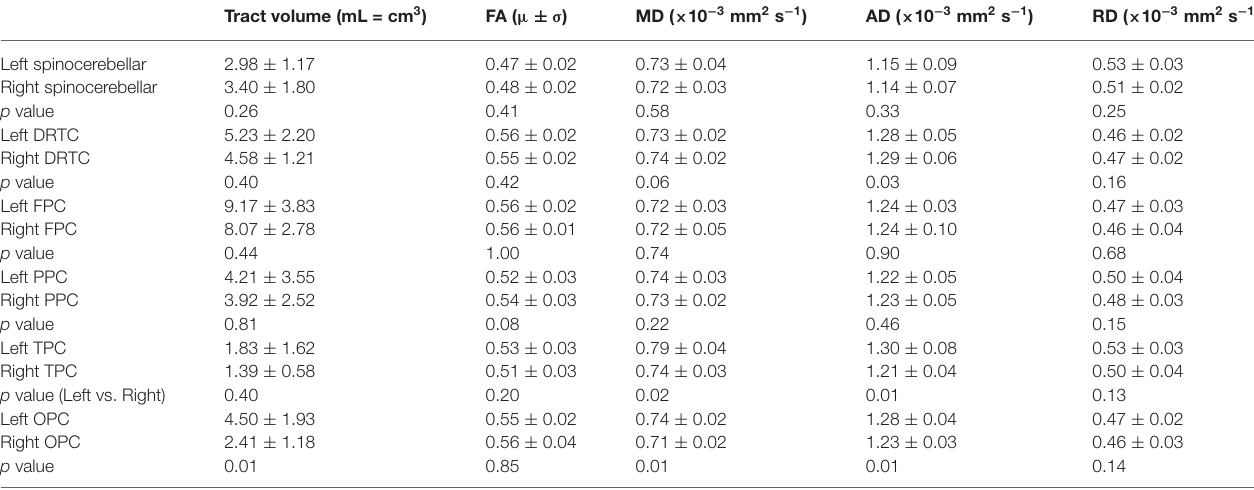
TABLE 2 | Group mean and standard deviation of DTI-derived attributes of the cerebellar pathways bilaterally along with the p values obtained from paired t -test between left-right sides .